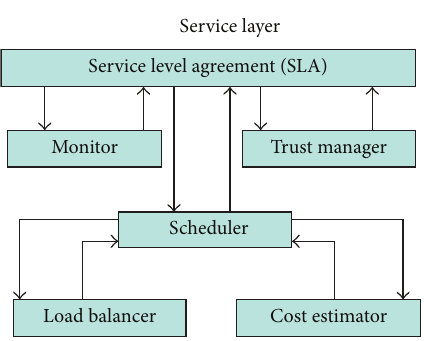
Figure 2: Service